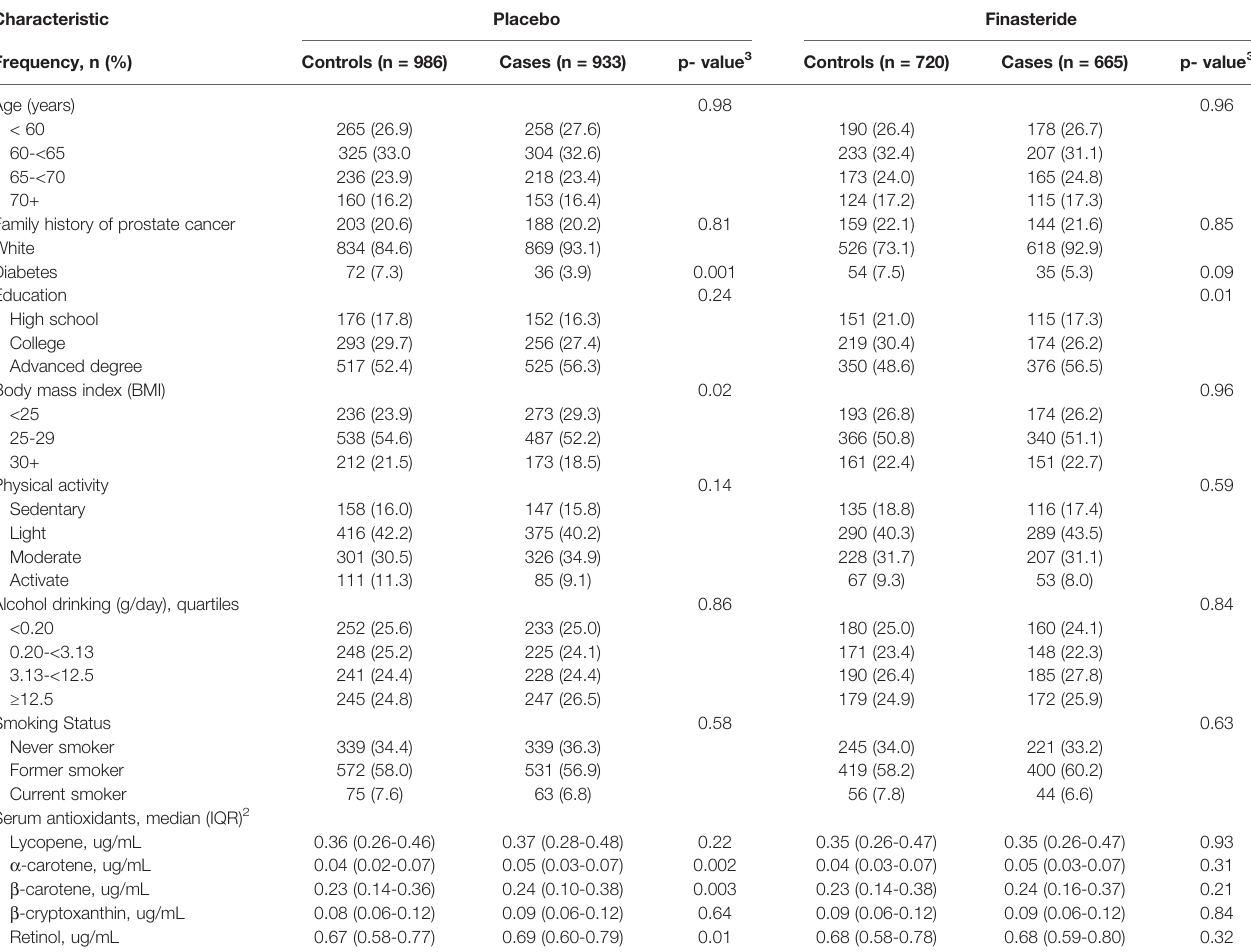
TABLE 1 | Baseline characteristics of participants 1 in the Prostate Cancer Prevention Trial (PCPT).